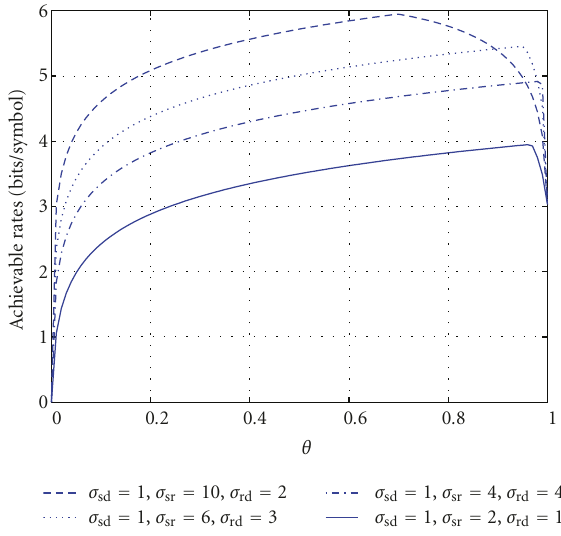
Figure 13: Nonoverlapped Parallel coding DF rate versus θ . P = 1, and m = 50.